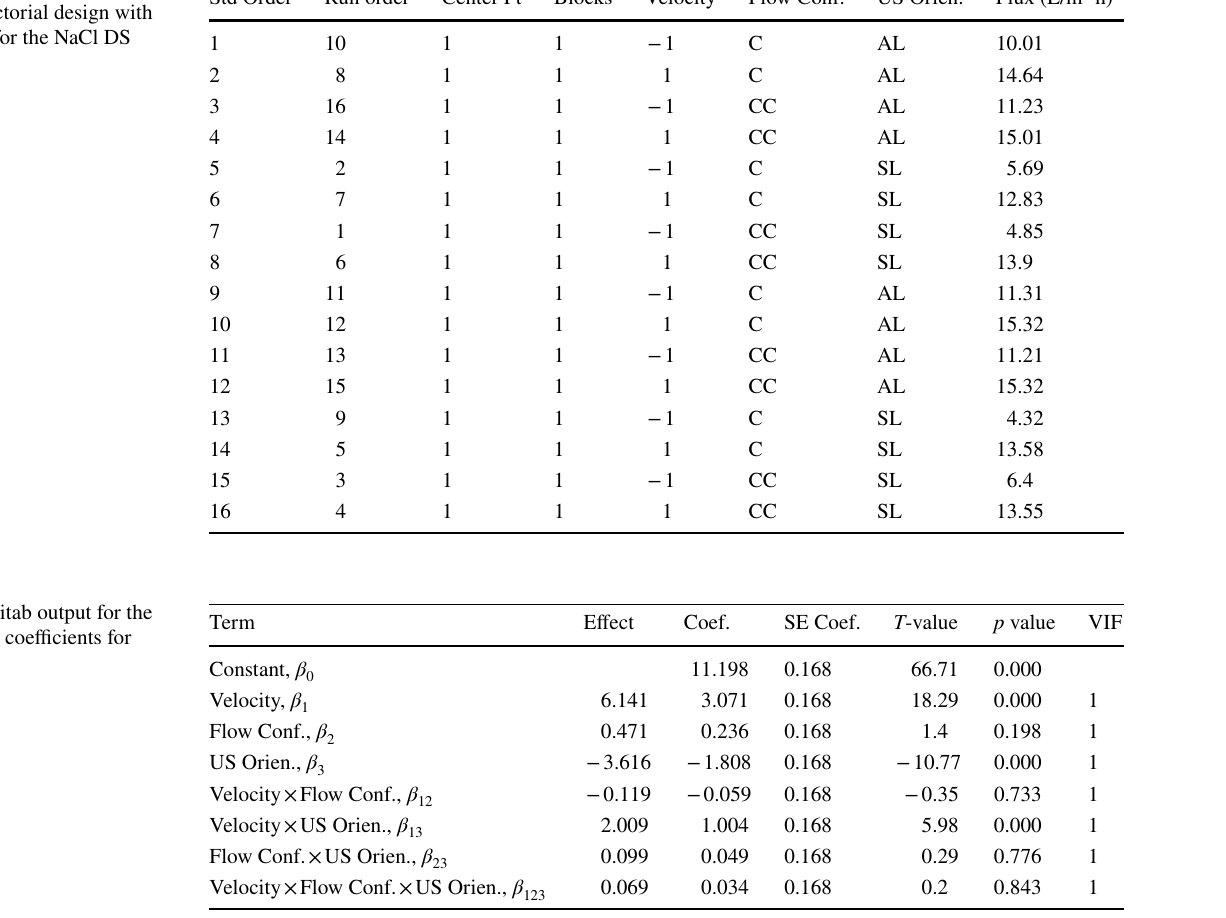
Table 4 Minitab input matrix for 2 3 full factorial design with 2 replicates for the NaCl DS